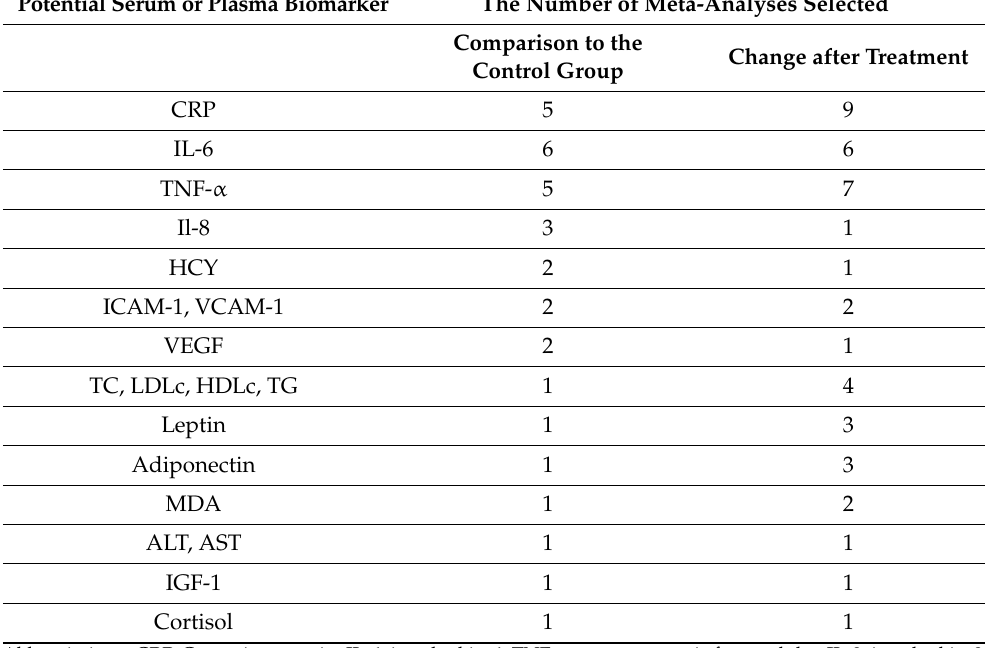
Table 2. Number of chosen meta-analyses regarding individual potential biomarkers.